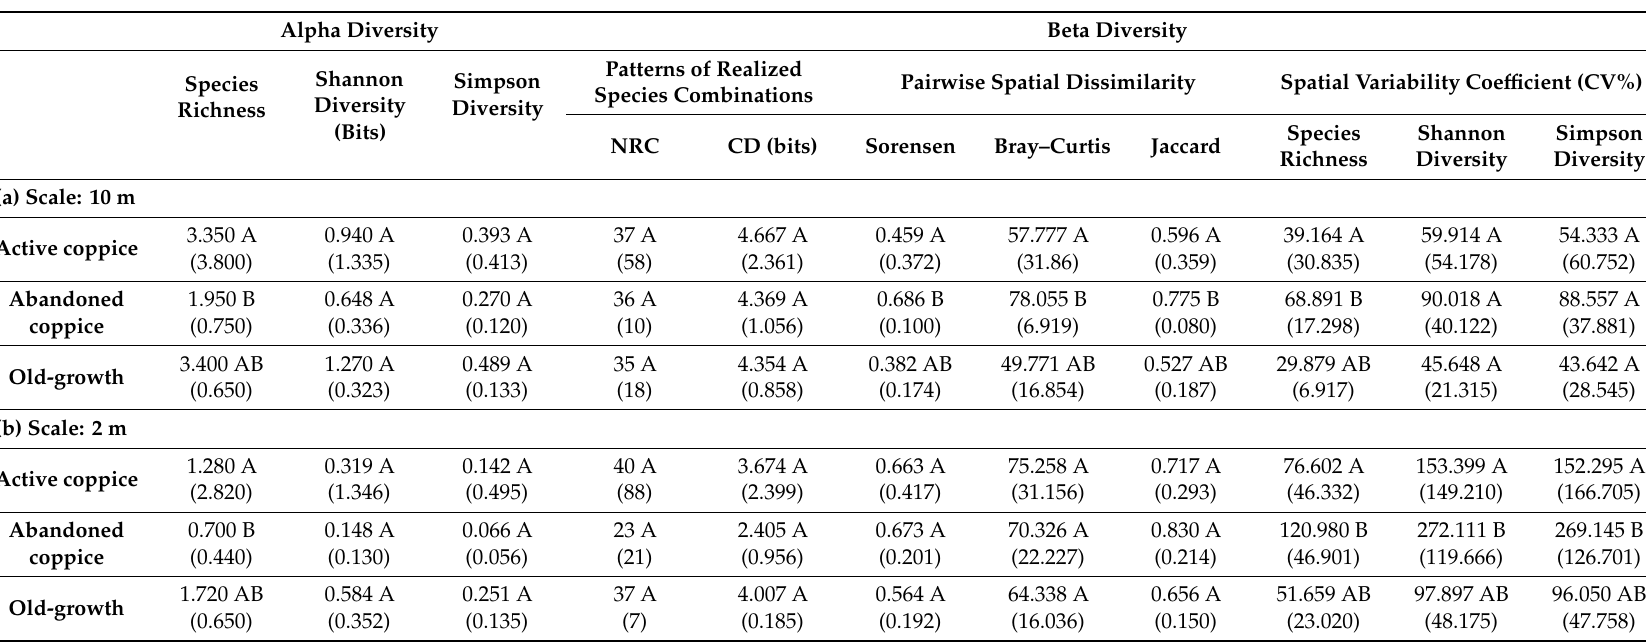
Table 3. Medians and ranges of estimated diversity characteristics of beech forest specialists in the successional stages. Significant di ff erences between stages were evaluated by the Kruskall–Wallis non-parametric rank test and indicated by letters (p < 0.05 Bonferroni adjusted post-hoc